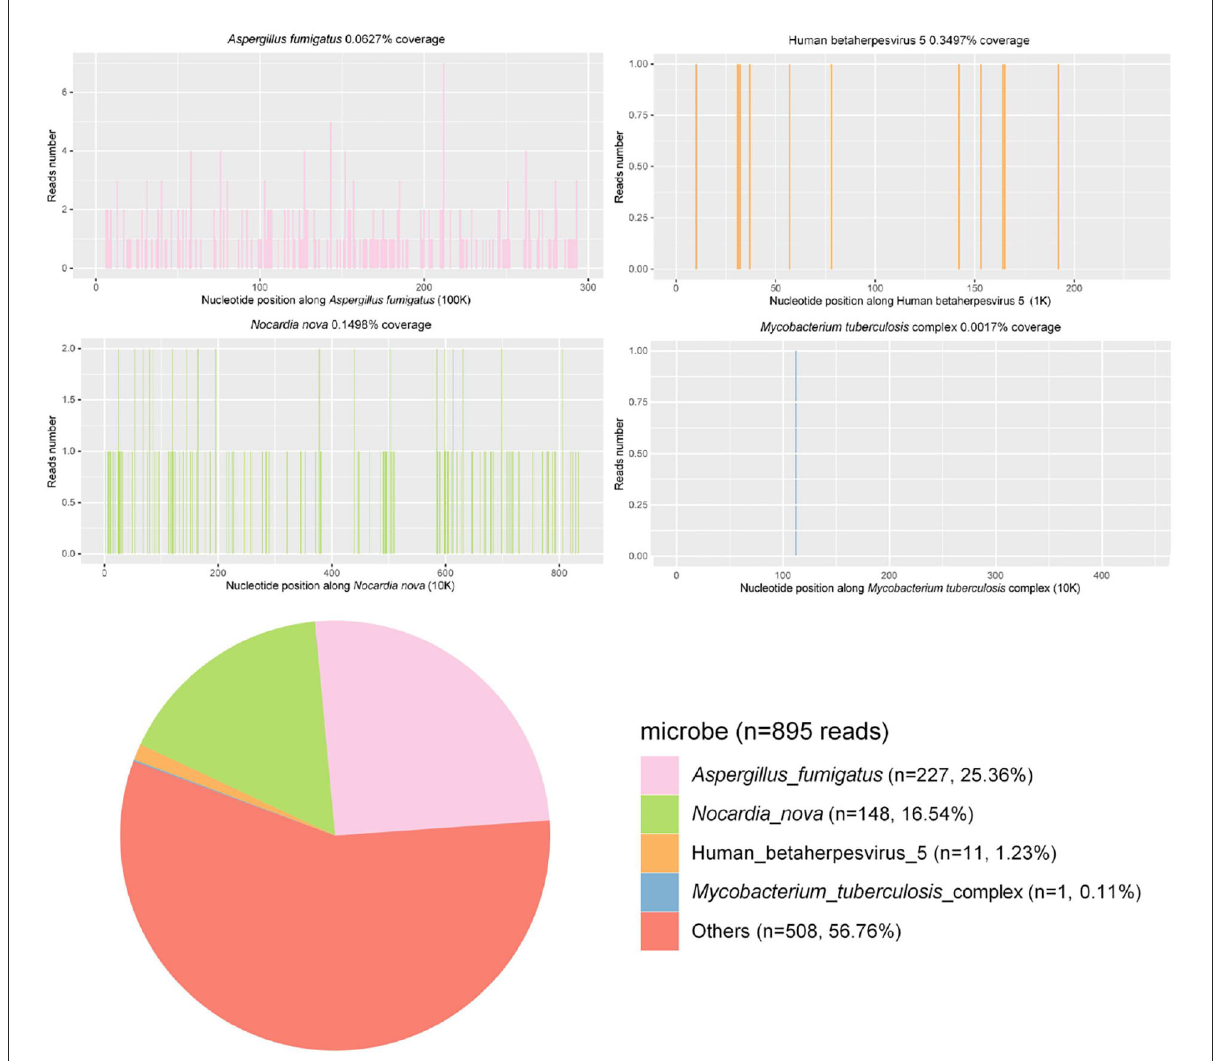
FIGURE2 Results of the metagenomic next-generation